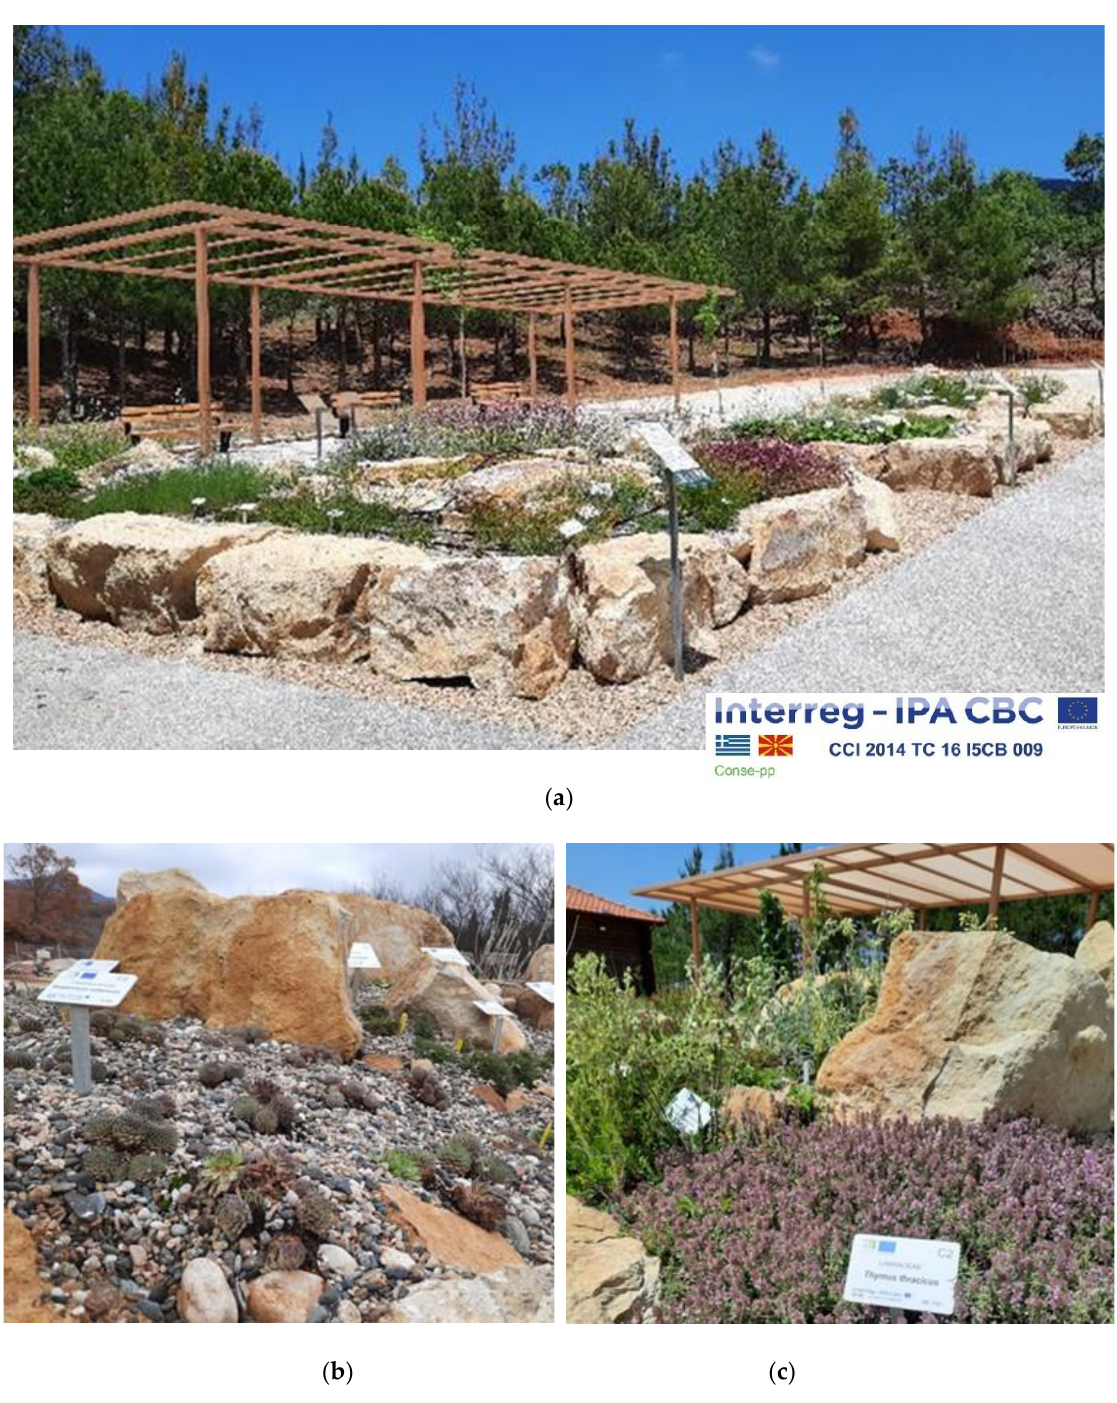
Figure 9. ( a ) Representative overview of the new thematic display ‘Rock gardens with A, B, C con- servation priority plants’ as implemented at the grounds of the Balkan Botanic Garden of Kroussia, Northern Greece within two years, using material of wild-growing plants that have been conse- quently propagated and acclimatized in man-made environments; Priority C2 plants rocky bed with Sempervivum ruthenicum ( b ) and Thymus thracicus ( c ).